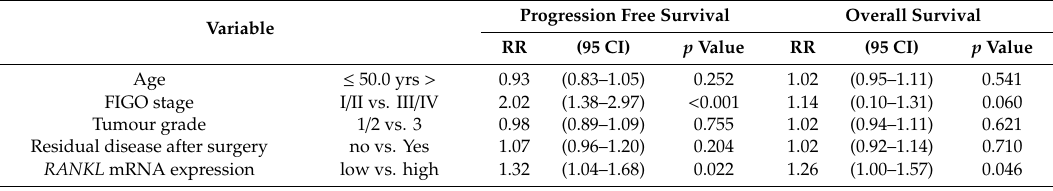
Figure 3. Validation of the prognostic impact of RANKL in the TCGA dataset. RANKL mRNA expression ( n = 563) and ( A ) progression free survival and ( B ) overall survival. Table 2. Multivariate survival analysis in 514 ovarian cancer patients from the TCGA Affymetrix dataset.